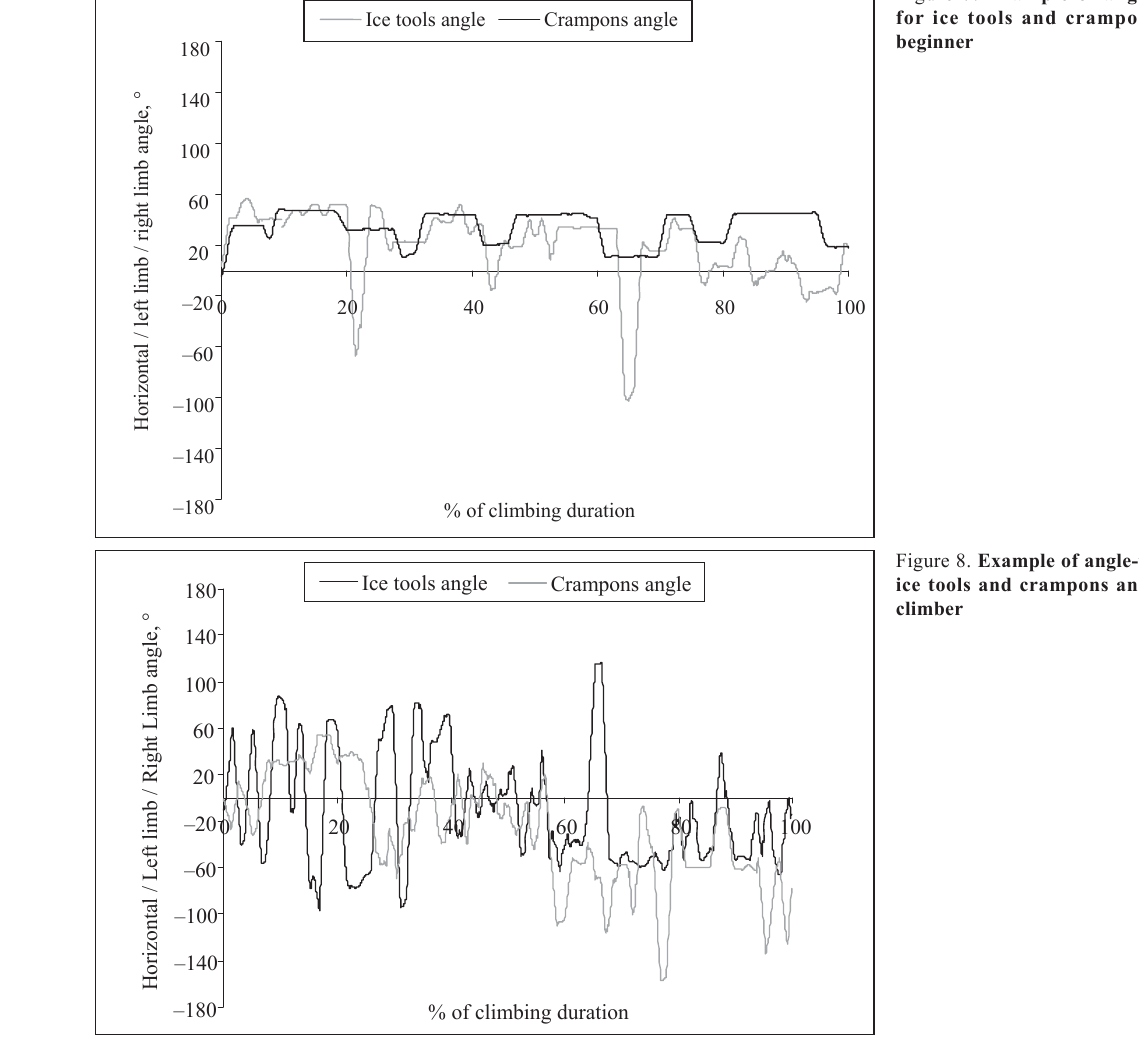
Figure 7. Example of angle-time curve for ice tools and crampons angle of a beginner